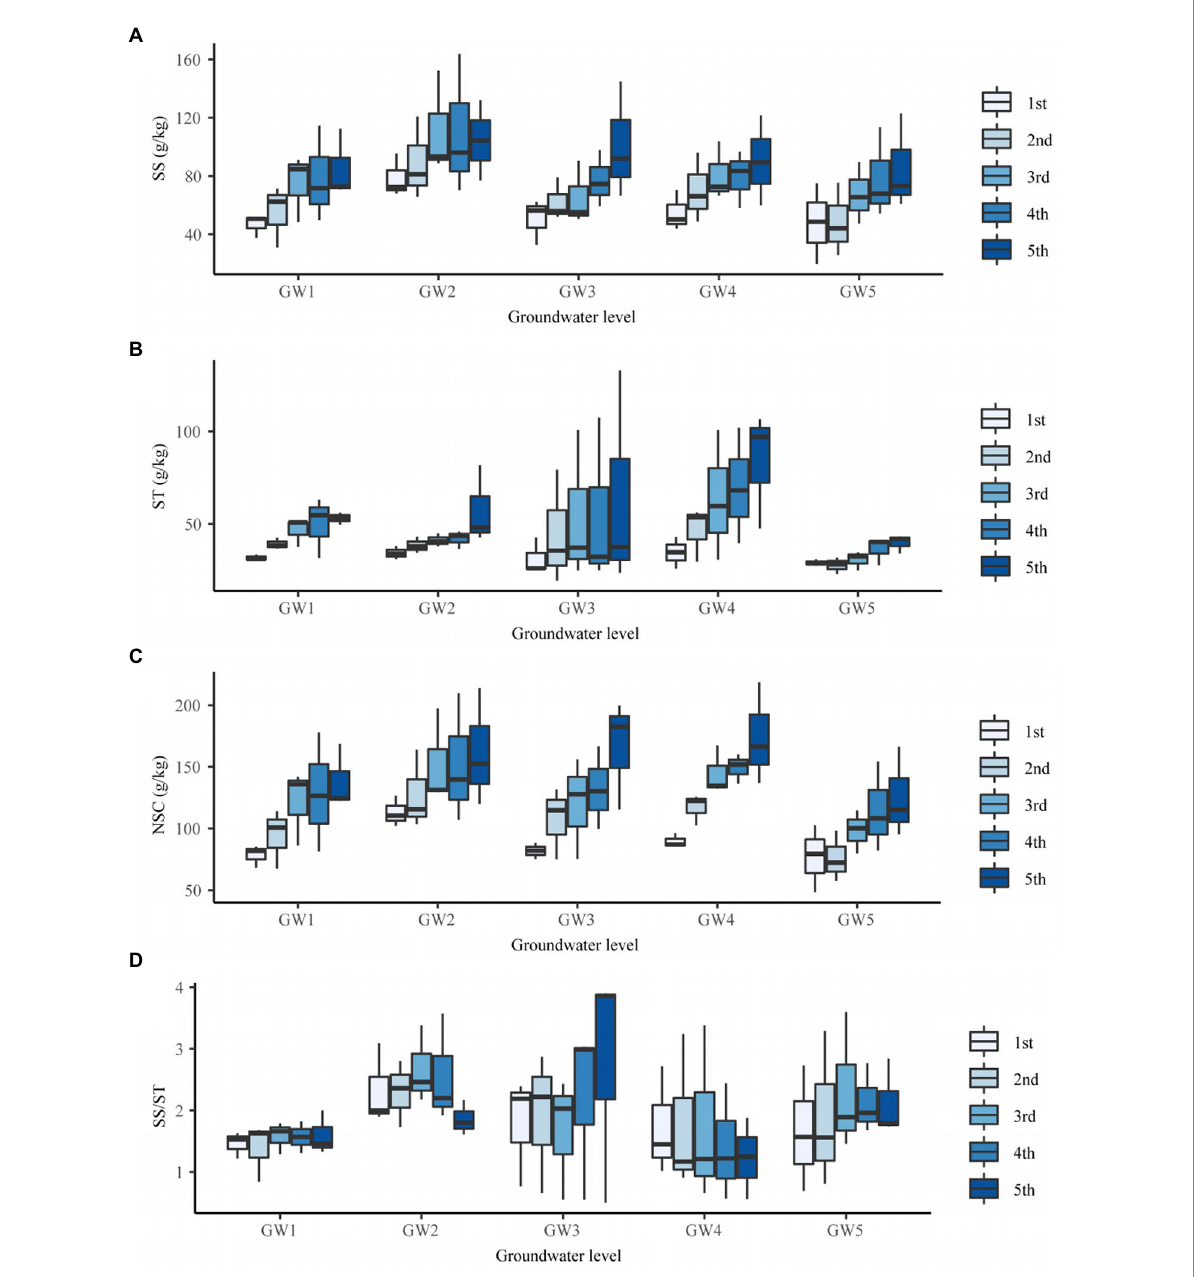
FIGURE 4 The SS content (A) , ST content (B) , NSC content (C) , and SS/ST (D) of fine roots of different order of Tamarix chinensis at different groundwater levels. SS, Soluble Sugar; ST, Starch; NSC, nonstructural carbohydrate; SS/ST, Soluble